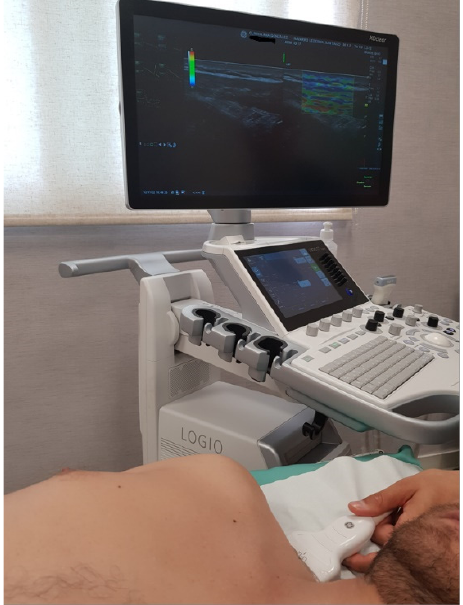
Figure 1. Strain elastography assessment of the midpoint of the upper trapezius.